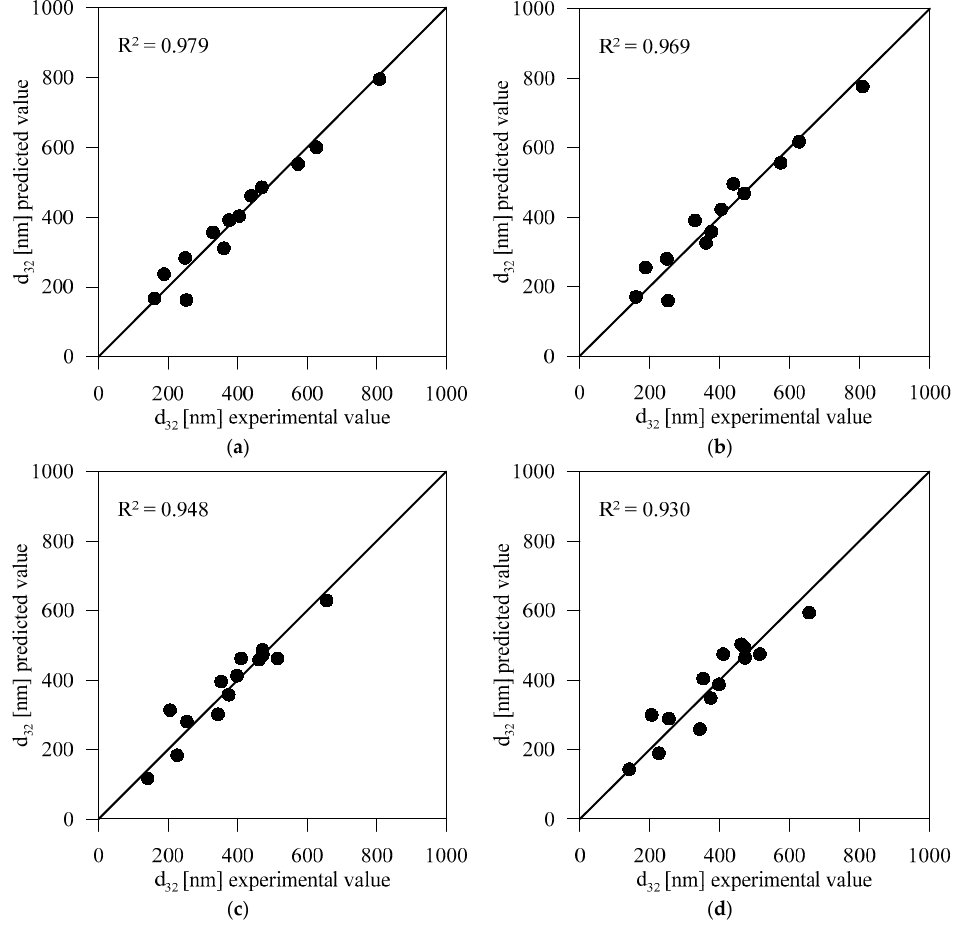
Figure 3. Parity plots for full statistical models and refined models. ( a ) the full model for oxygen bubbles, ( b ) refined model for oxygen bubbles, ( c ) full model for hydrogen bubbles, ( d ) refined model for hydrogen bubbles.